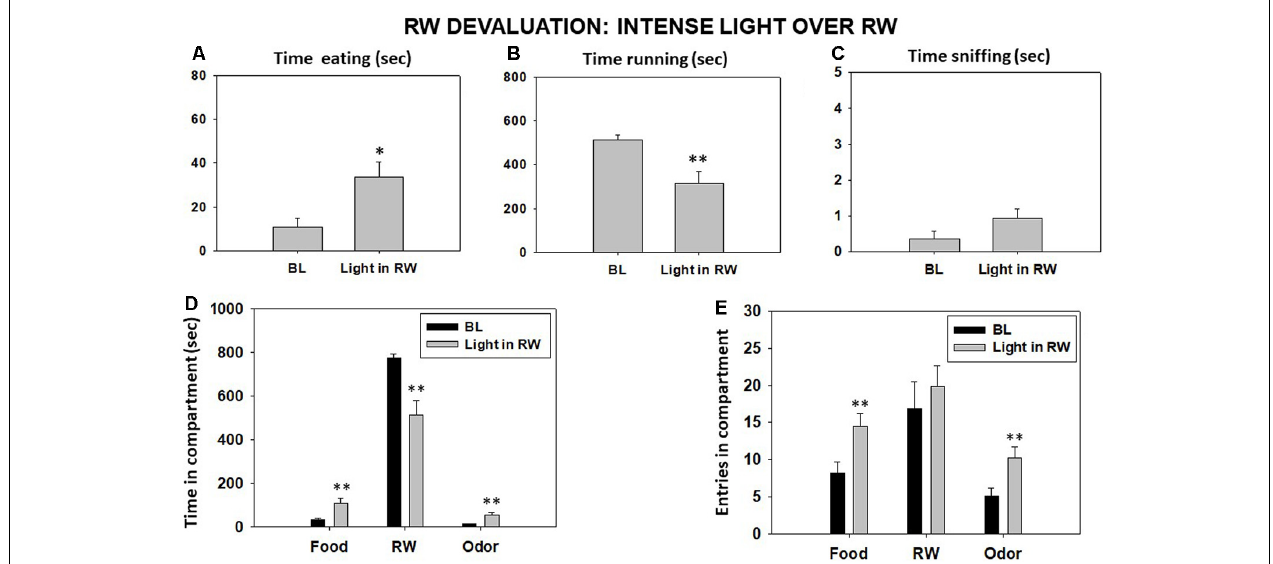
FIGURE 7 | Effect of placing an intense light over the RW on time eating (A) , time running (B) , time sniffing (C) , time spent in each compartment (D) , and entries into compartments (E) in the T-maze task assessed during 15 min. Bars represent mean ± SEM of accumulated seconds or number of entries. ∗ p < 0.05, ∗∗ p < 0.01 significantly different from